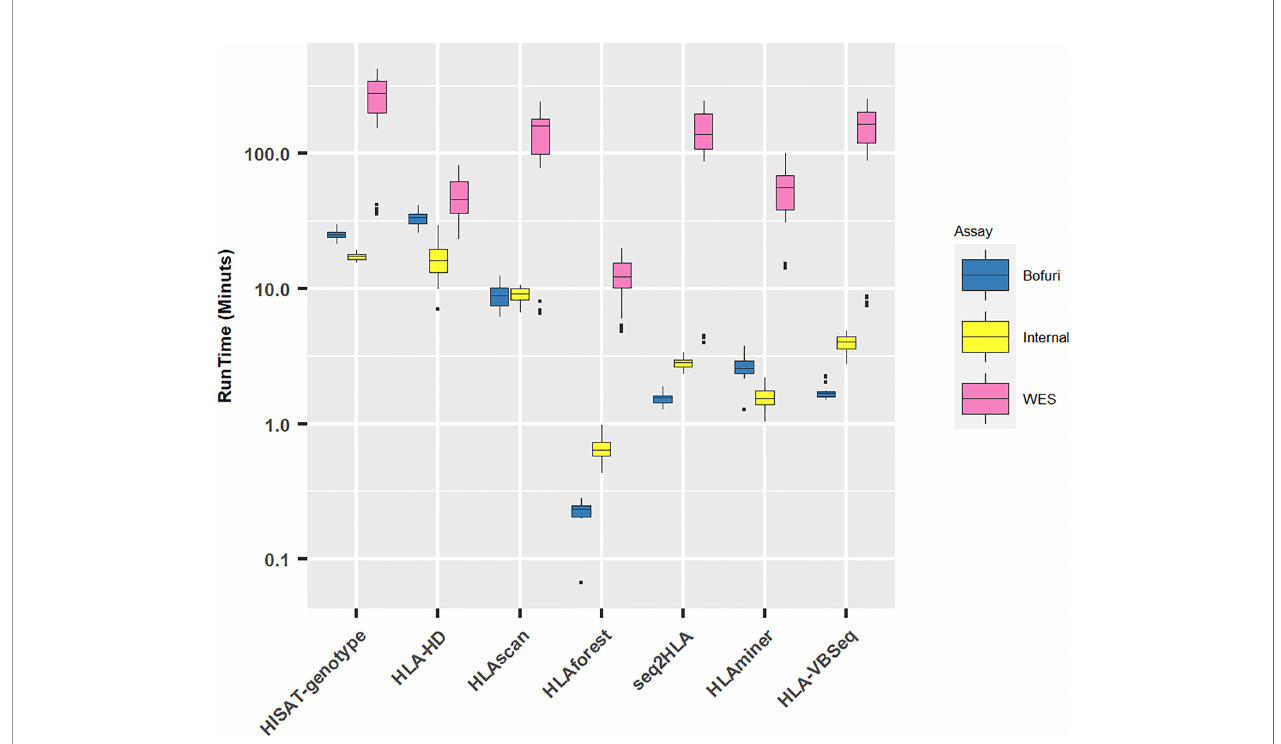
FIGURE 3 | Running time for different HLA typing software. Y axis is plotted in log10